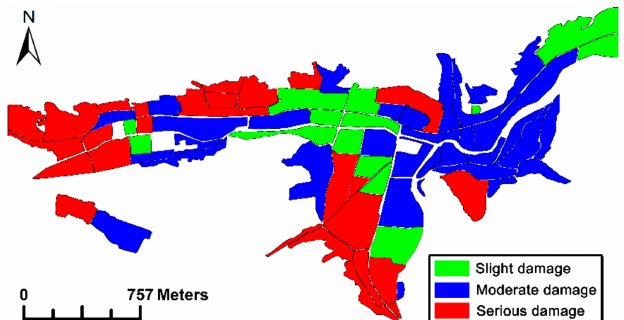
Figure 4. Reference map of the building earthquake damage assessment at the city block scale for the Yushu urban region. If more than half of the buildings were damaged after the earthquake, the city block was considered as serious damage. The city blocks with less than one-third of the buildings damaged were considered as slight damage. The city blocks with a damage level between slight damage and serious damage were considered as moderate